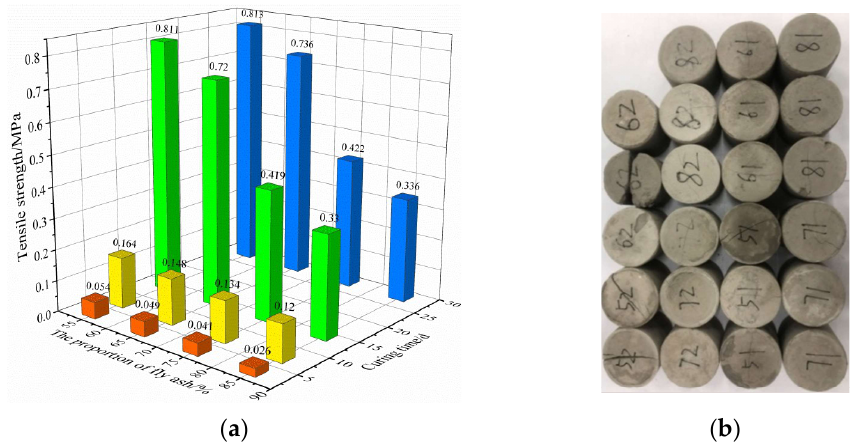
Figure 6. The tensile strength of CMFB and the physical map of specimens. ( a ) The tensile strength of CMFB with various curing times and fly ash contents; ( b ) the physical map of some specimens after the Brazilian splitting test.